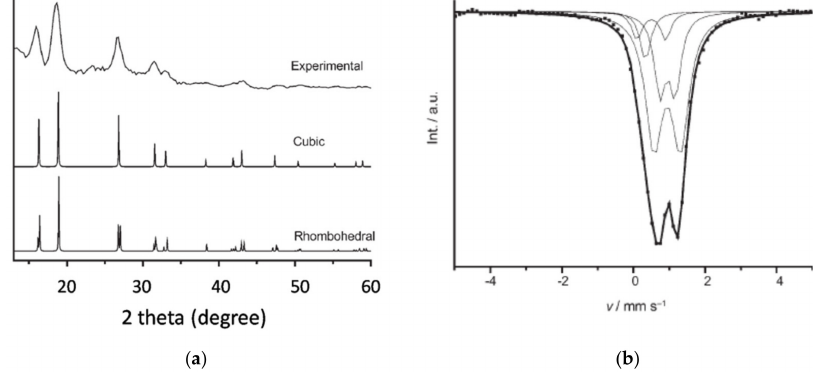
Figure 5. ( a ) XRD pattern of FeO nanoparticles: ( b ) Mössbauer spectrum of FeO nanoparticles at room temperature. Obtained permission from Ref. [54]. Copyright 2008 John Wiley and